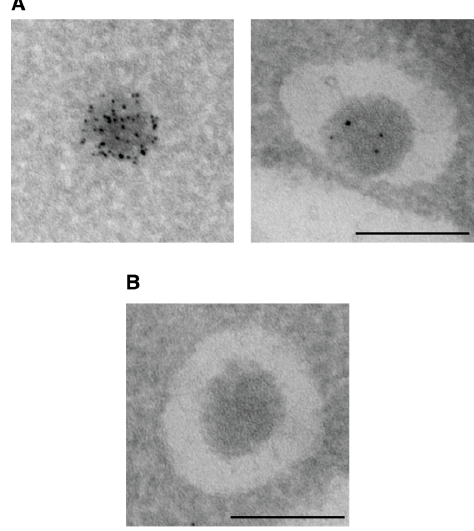
Figure 8. Identification of Cvt vesicles in immuno-electron microscopy. ( A ) Immuno-labeling of Ape1 with gold-coupled antibodies is commonly used to identify Cvt vesicles. Ape1 oligomers before ( left ) and after ( right ) sequestration in a Cvt vesicle are shown. ( B ) The unique ultrastructure of the Ape1 oligomer can be easily recognized even in the absence of gold particles. ( A , B ) Due to the low protein content of autophagic membranes, these membranes appear as a white halo-like ring around the Ape1 oligomer. Mid-log phase cells were fixed, embedded and cryo-sectioned by the Tokuyasu method as described in [72]. Ape1 was visualized with an anti-Ape1 antibody recognized by a gold-coupled (6 nm) secondary antibody. Scale bar: 200